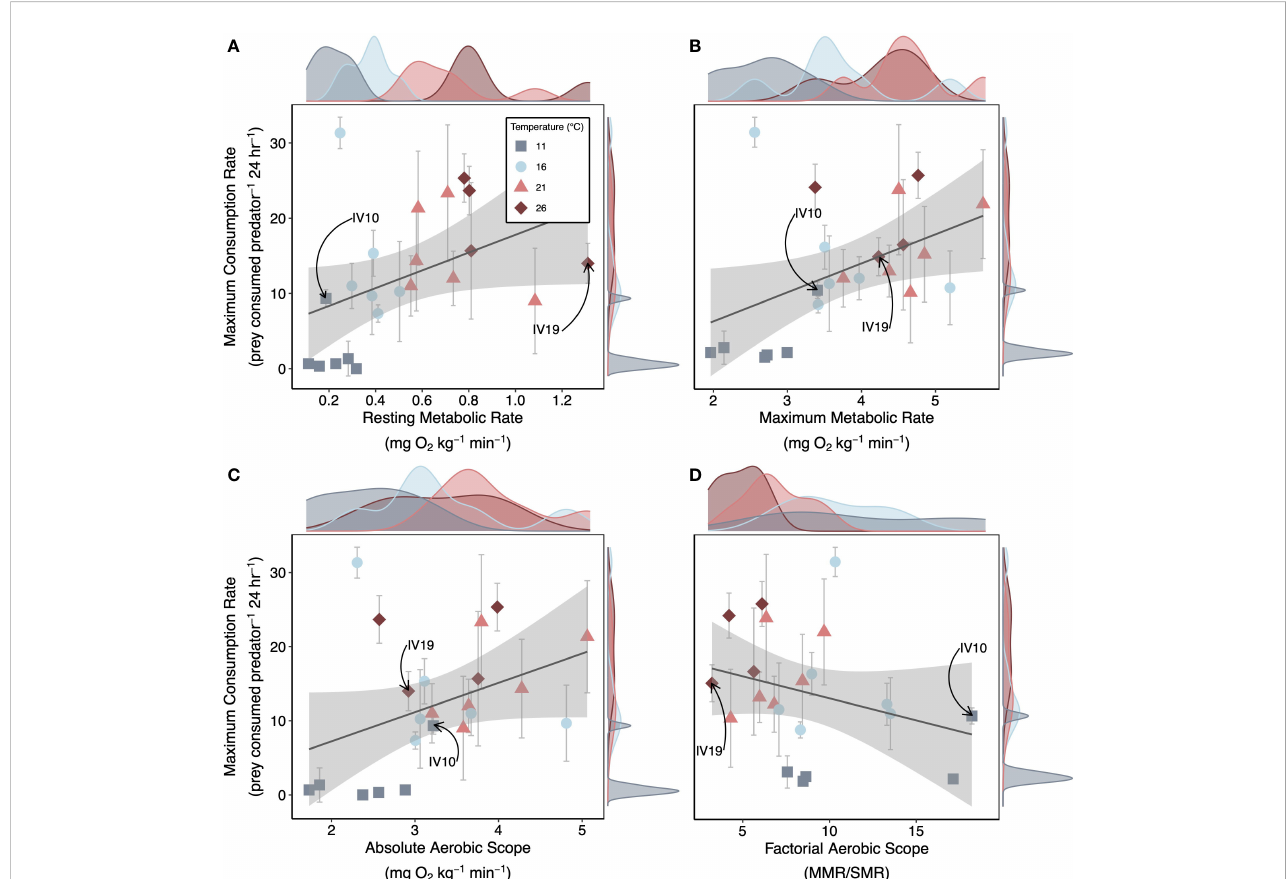
FIGURE 5 Metabolism Effects on Foraging Across Temperatures. Median posterior estimates for the maximum consumption rate ( C max ) of each individual lobster plotted as a function of the individuals (A) resting metabolic rate, (B) maximum metabolic rate, (C) absolute aerobic scope and (D) factorial aerobic scope across temperatures. Gray error bars are the 95% CI ’ s of the median estimate from the posterior distribution. Lines and gray shading are mean linear trends and 95% CI ’ s from simple linear regressions fi t to the median estimates of C max . Density plots show the distribution of metabolic traits (x-axis) and C max (y-axis) for each treatment. We provide an example of an individual we characterized as an overperformer (IV10; 11°C treatment) and as an underperformer (IV19; 26°C treatment) as compared to treatment